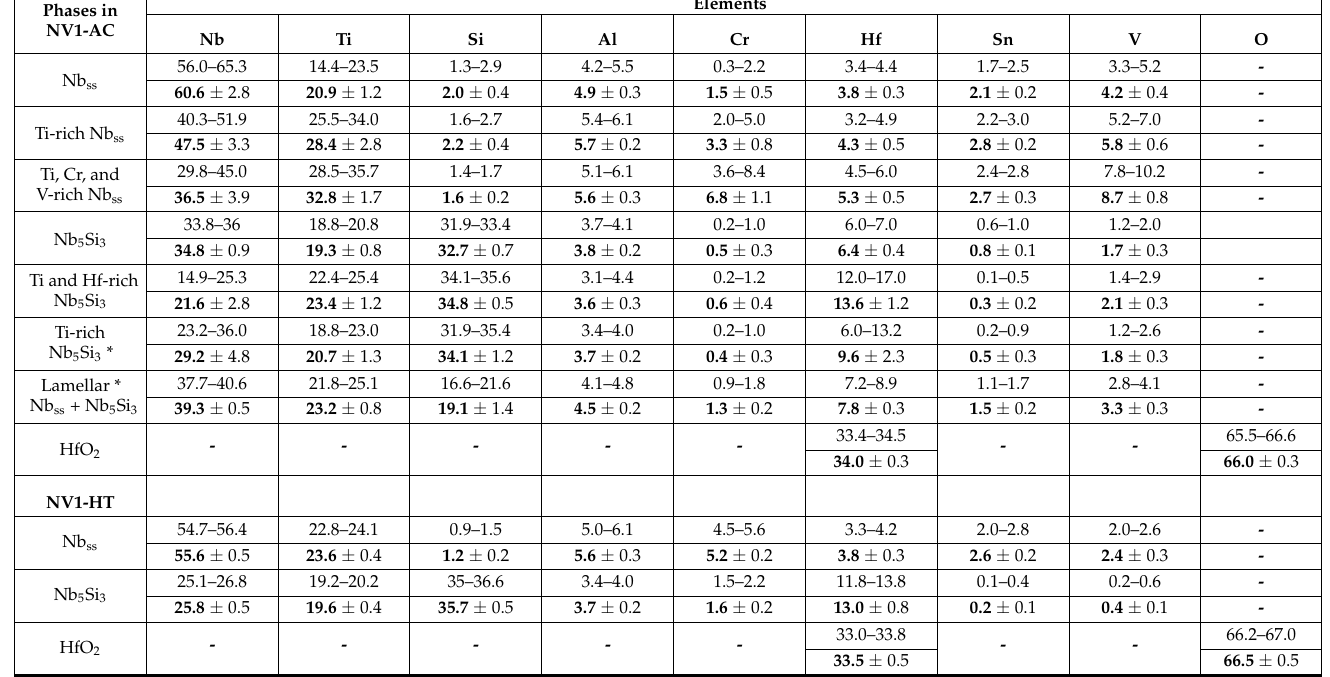
Table 2. EPMA data (at.%) of phases in NV1-AC and the bulk of NV1-HT. (Average values are shown in bold numbers). Phases in